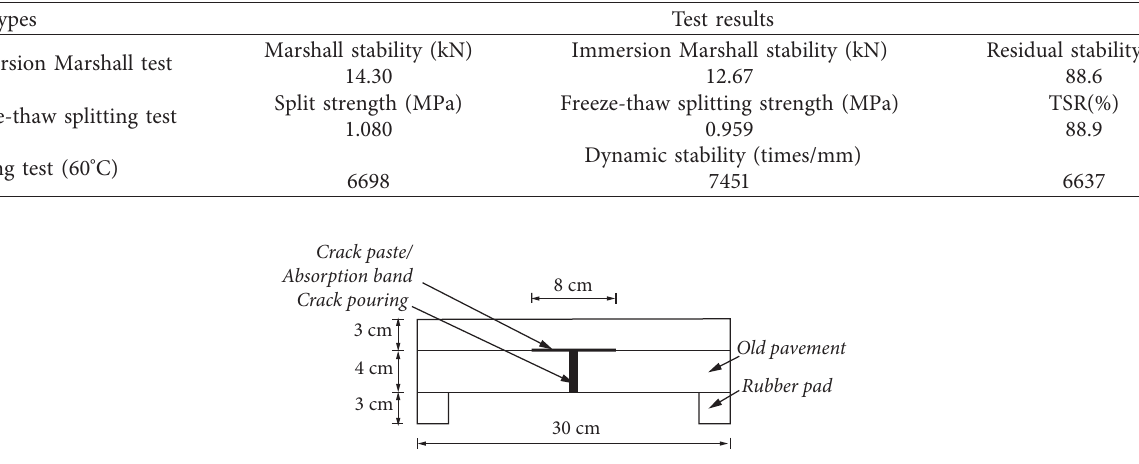
Figure 1: Structural model of the anticracking treatment test on the beam-like pavement with simply supported